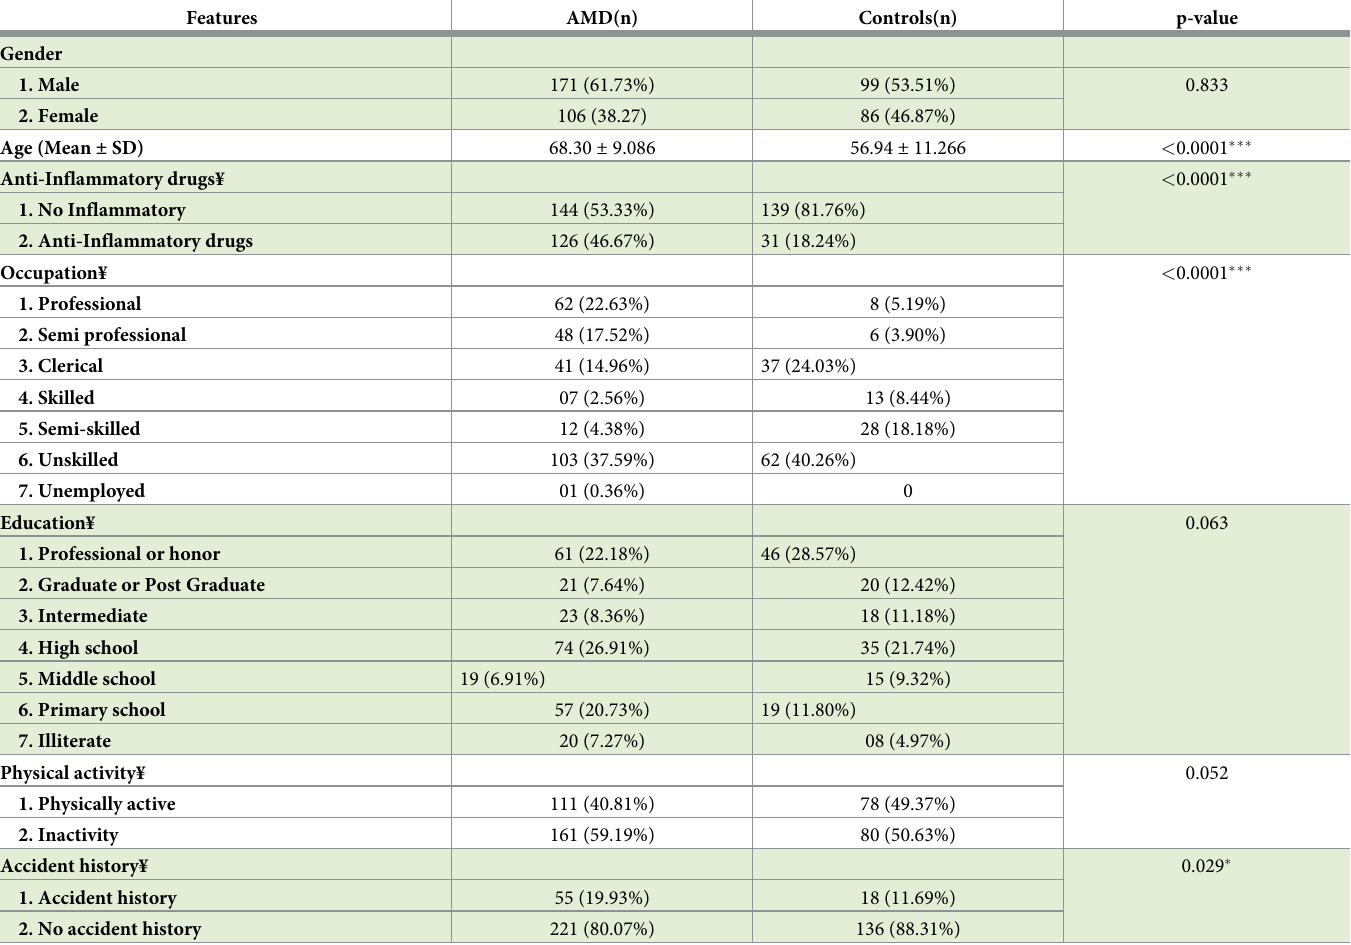
Table 1. Comparative demographic characteristics of AMD and